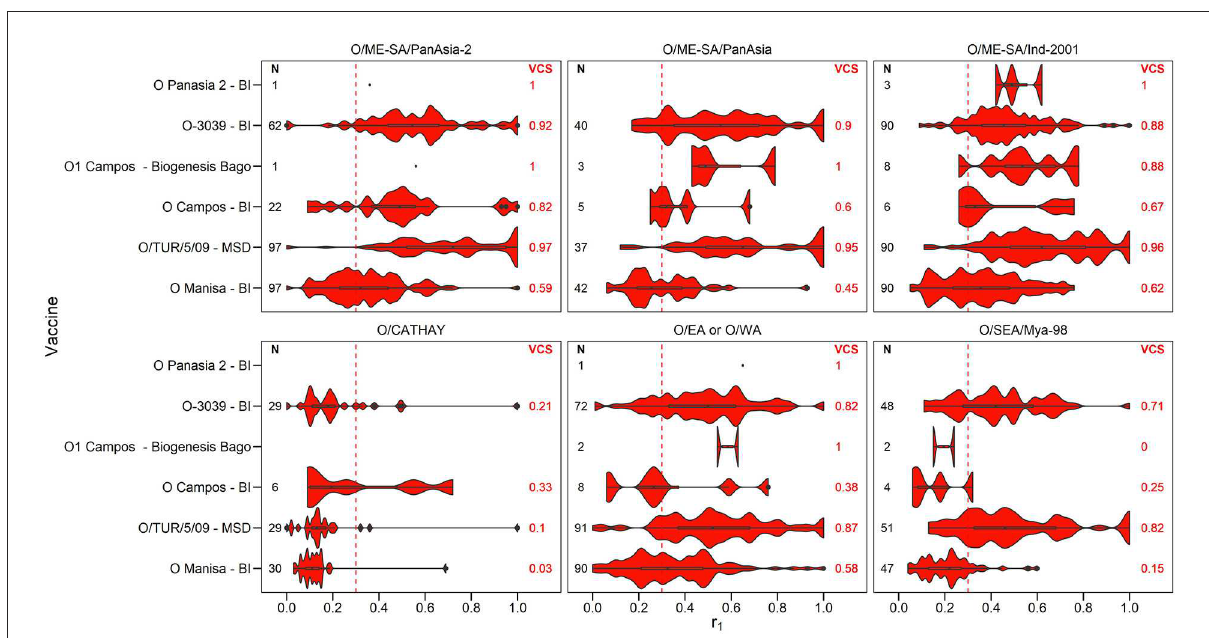
FIGURE2 Violin plots showing results of vaccine matching tests performed at the WRLFMD between 2011 and 2021, for each vaccine/lineage combination for serotype O. Resulting vaccine coverage scores (VCS) are labeled on the right in red, and the number of tests performed are labeled on the left in black. The red dashed line shows the r 1 cut-off of 0.3 indicative of an effective vaccine match. Values for lineage EURO-SA are not shown as there was only one test performed for each of the vaccines O Campos (BI), O1 Manisa (BI MSD) and O/TUR/5/09 (MSD), with all r 1 values being above